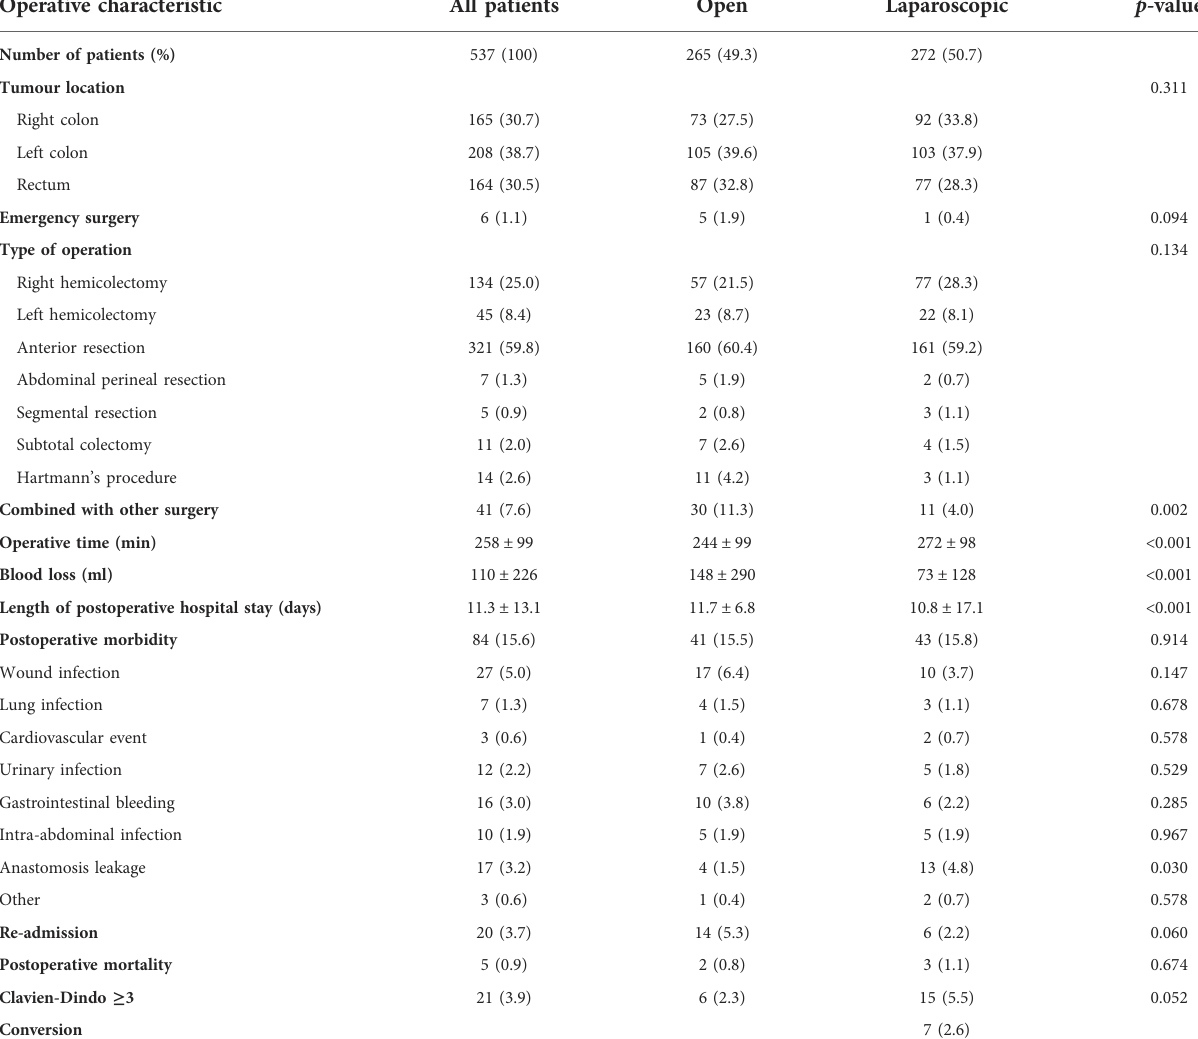
TABLE 2 Operative characteristics of the study patients. Operative characteristic All